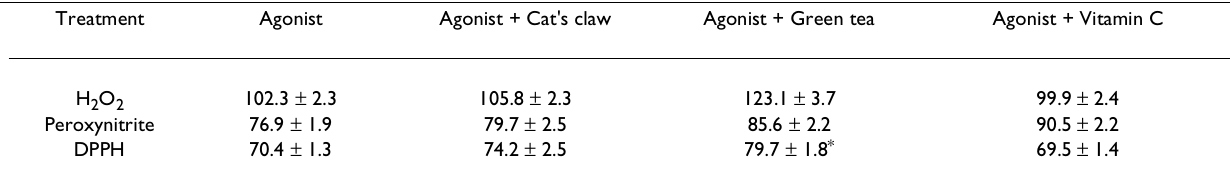
Table 3: Changes in IEC-18 Cell Viability (MTT Assay) in Response to Oxidants and the Effects of Dietary Antioxidants